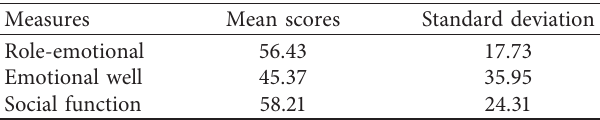
Table 1: Mean of the score of the measures of emotional quality of